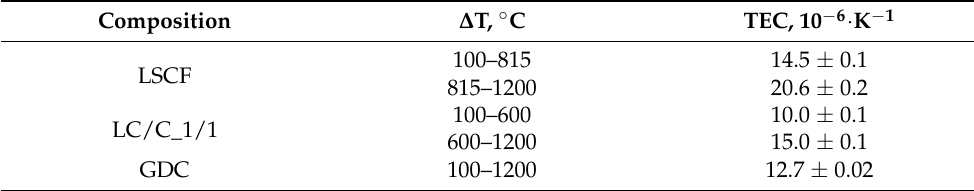
Figure 1. Linear shrinkage curves for the investigated materials. Table 2. TE С of the investigated materials. Table 2. TEC of the investigated materials.